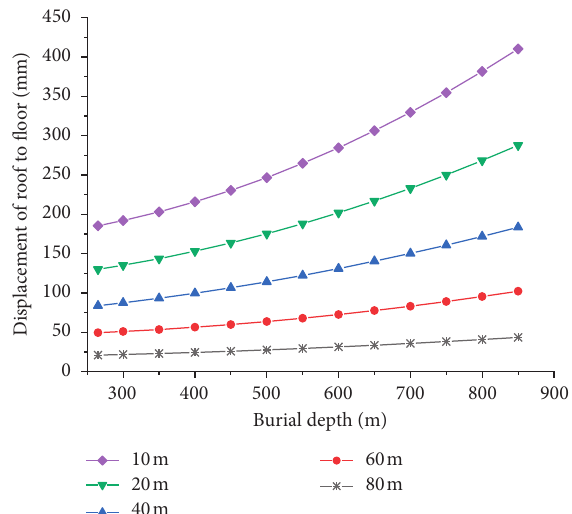
Figure 22: Comparison of displacement of roof to